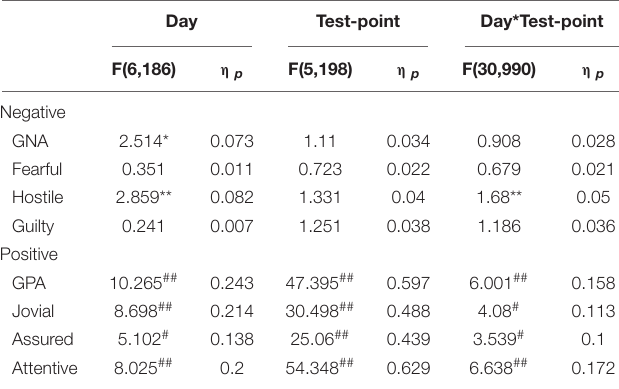
TABLE 4 | Effects of circadian phase on Negative and Positive